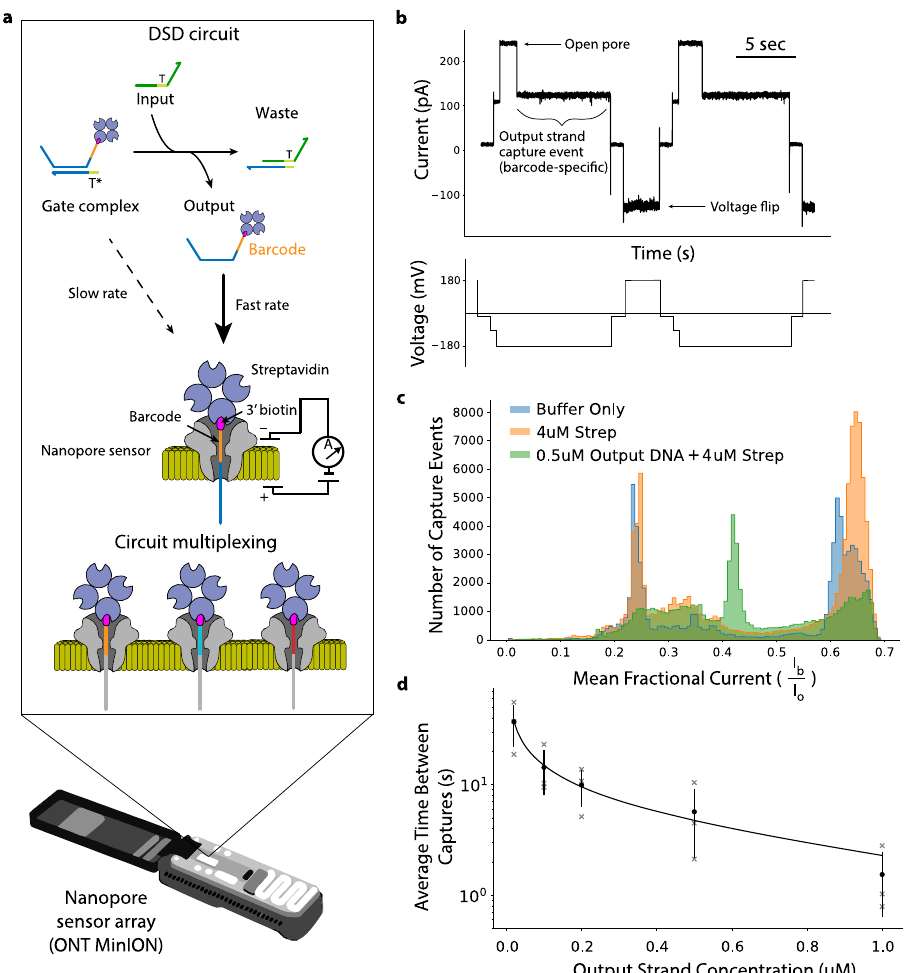
Fig.1|NanoporedetectionofDNAcircuitoutputs.a DSDcircuitdetectionwitha nanopore sensor. Circuit components are mixed and loaded onto a nanopore sensor array for real-time readout. Input strands react with the gate complex dis- placingthebarcodedand3 ’ labeledbiotin-streptavidinoutputssDNA,whichisthen free to be captured and read by a nanopore sensor. The nanopore sensor array is capable of distinguishing different output strand barcodes, enabling circuit mul- tiplexing. b Example raw nanopore data showing repeated capture and ejection of biotinylated ssDNA output strands. DNA capture events manifest ionic current